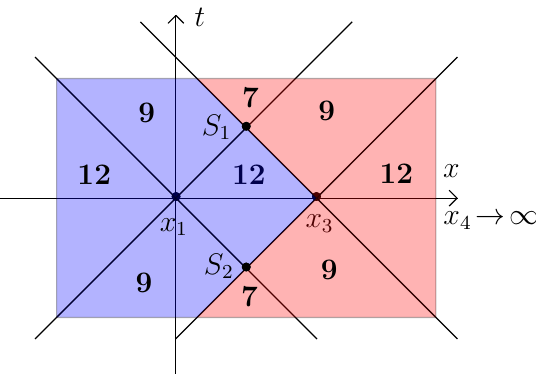
Figure 10 . Minkowski configurations with x 1 = 0 , x 3 = configurations where | ρ | , | ρ | < 1 and the 4-point functions is analytic. Red: configurations where | ρ | and/or | ρ | = 1 . Boldface numbers X = 7 , 9 , 12 denote the causal type of the configuration according to [37] (excluding lightlike separations). S